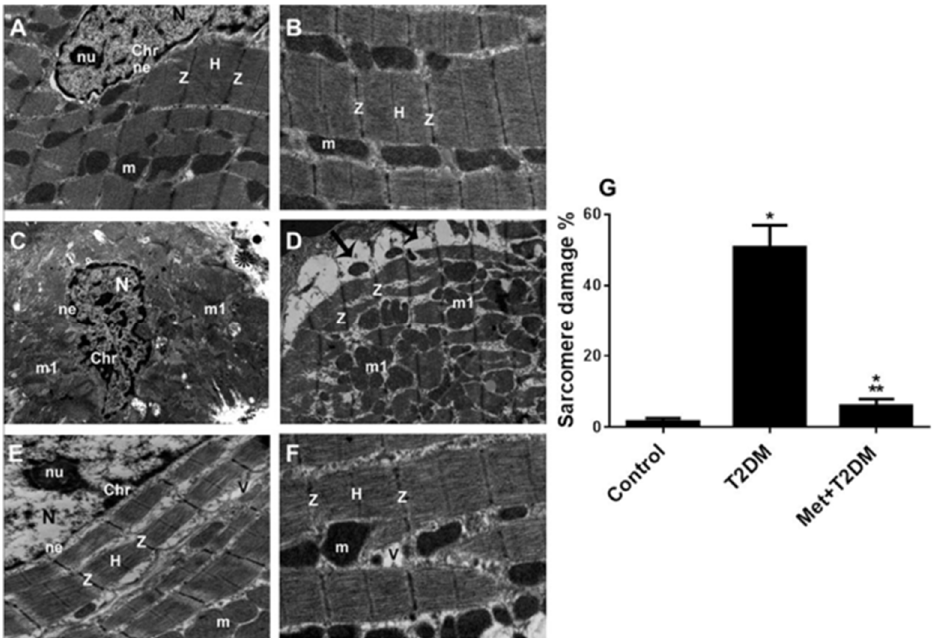
Figure 2. Metformin (Met) protects the cardiac ultrastructure against alterations secondary to T2DM. TEM images (10,000×) of left ventricles obtained 10 weeks post diabetic induction of untreated control ( A , B ), T2DM ( C , D ), and Met + T2DM ( E , F ) groups are illustrated. Note that the asterisk in ( C ) points to degenerated fragmented myofibrils, and the arrows in ( D ) point to the widely separated festooned sarcolemma. N: nucleus; nu: nucleolus; chr: chromatin; ne: nuclear envelope; V: vacuoles; m: mitochondria; m1: damaged mitochondria; H: H band; Z: Z discs; T2DM: type 2 diabetes mellitus. The histogram in ( G ) represents a quantitative analysis of % sarcomere damage in cardiac sections from the groups above. Presented p values are all significant. * p < 0.05 versus control, ** p < 0.0001 versus T2DM.